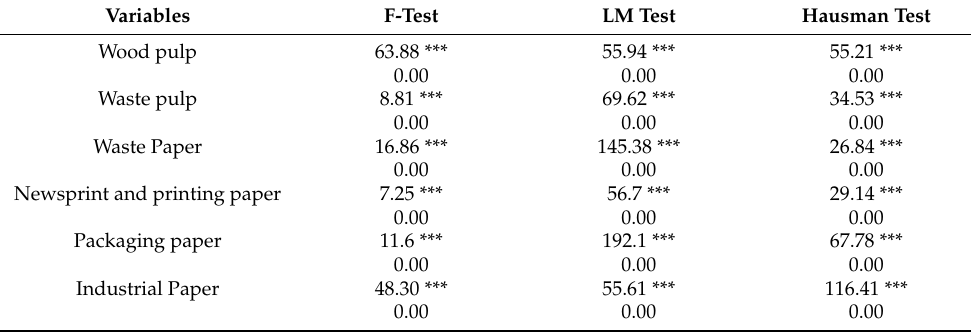
Table 3. Results of robustness